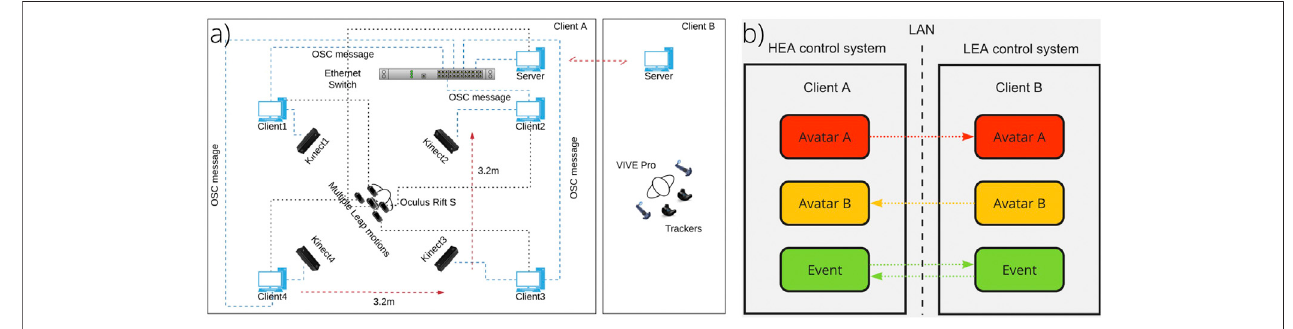
FIGURE 3 | Multiuser VR system. (A) System setup and (B)